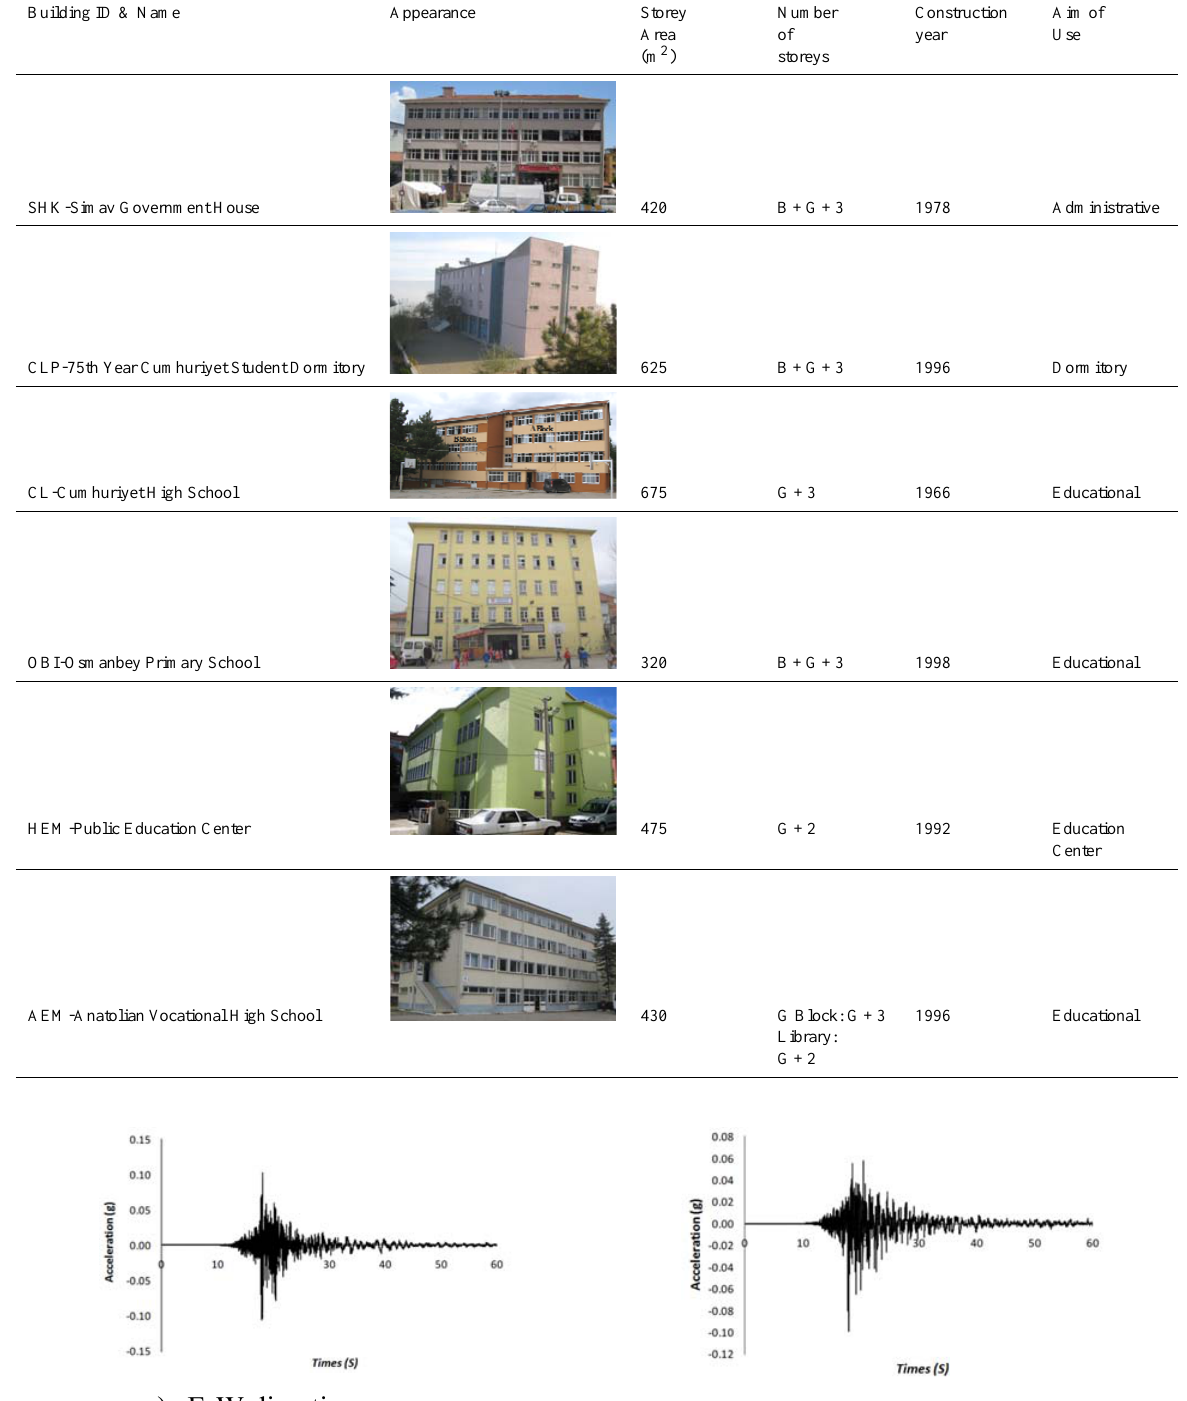
Table 1. Basic data of investigated buildings.